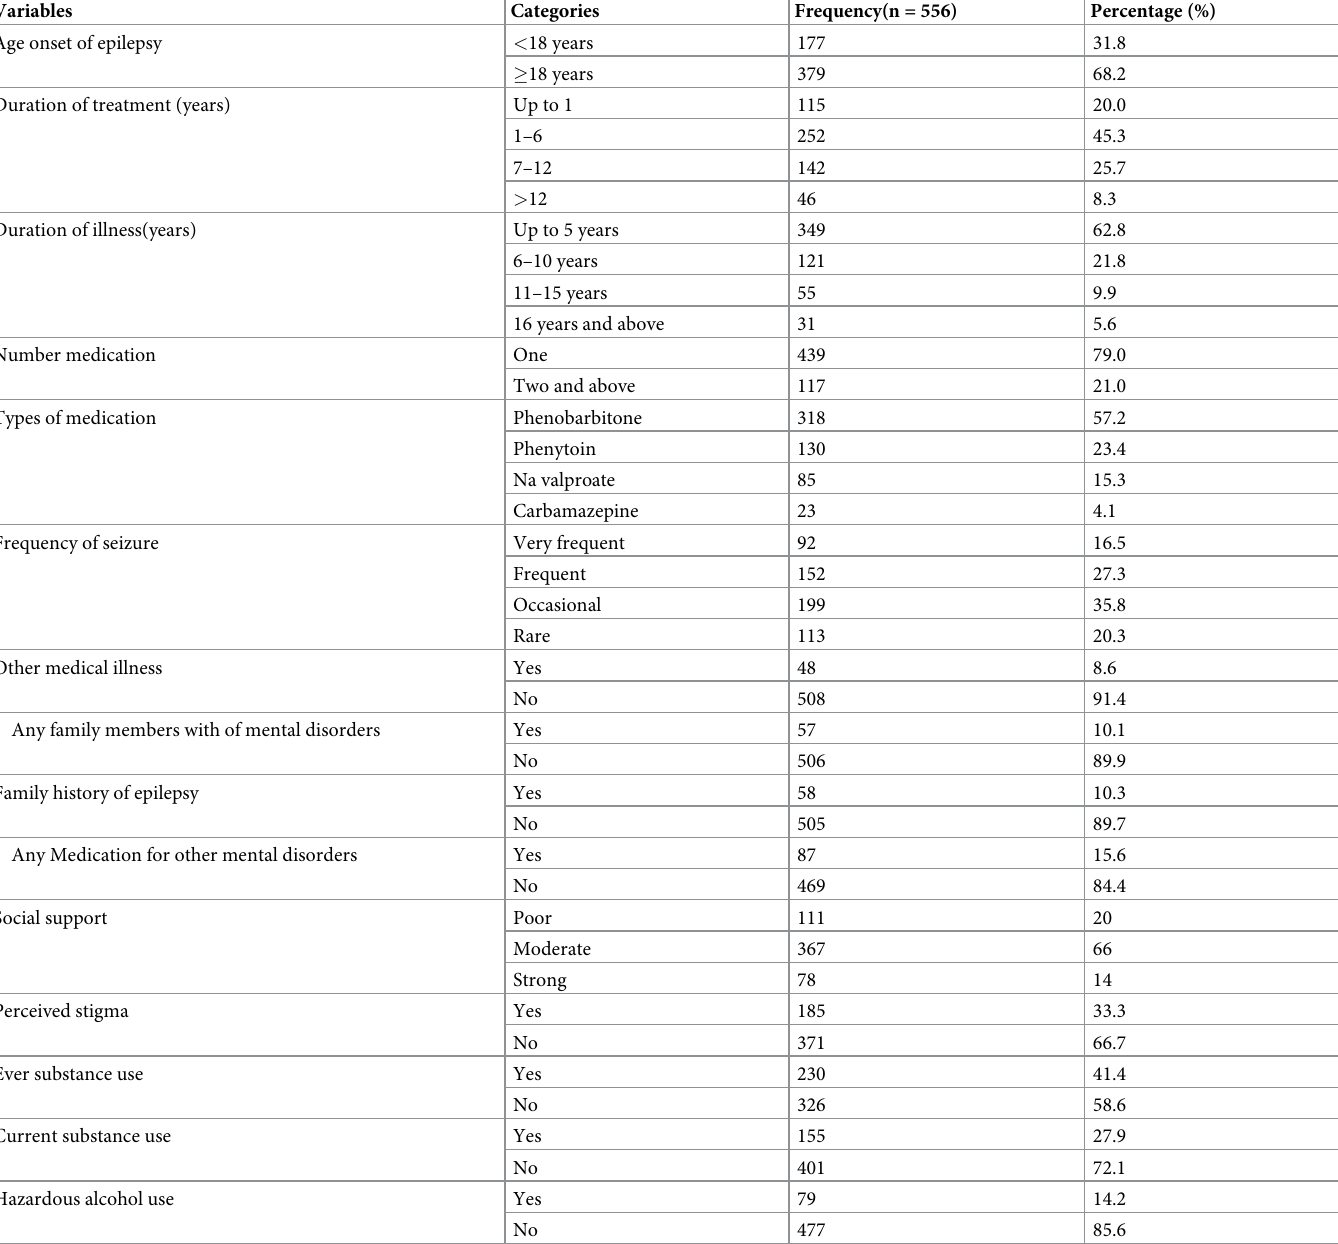
Table 2. Description of clinical, substance use, psychosocial features of people with epilepsy at central Gondar zone primary public hospitals, northern part of Ethi- opia (n = 556).